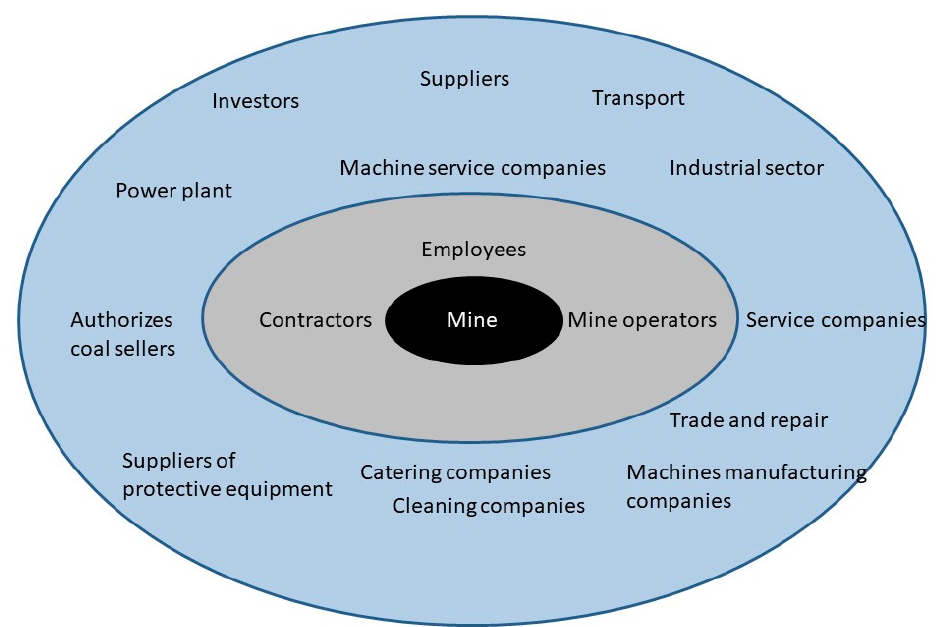
Figure 3. Jobs associated with mining divided into those in the close vicinity and those in the more distant surrounding area.